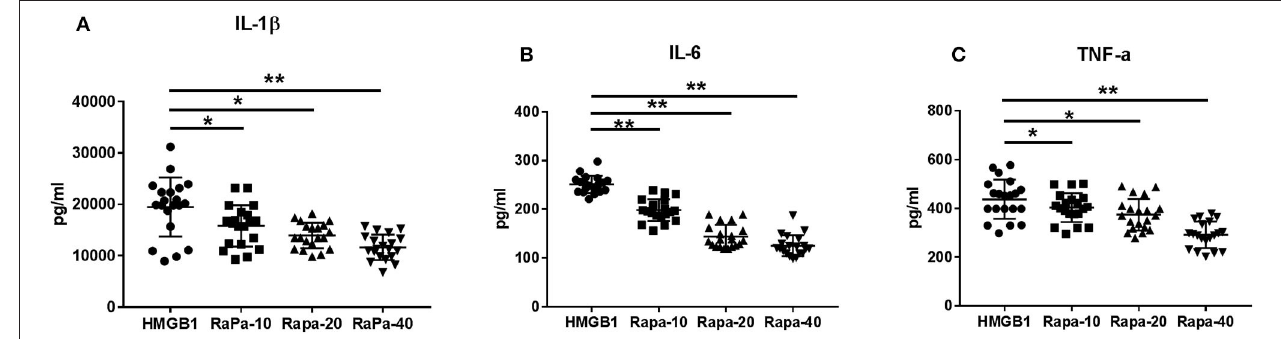
FIGURE 8 | Cytokine production through Rapa intervention. mDCs from systemic lupus erythematosus (SLE) patients were blocked by different concentrations of rapamycin, and production of IL-1 β (A) , IL-6 (B) , and TNF- α (C) were measured by ELISA. Different concentrations of rapamycin (Rapa-10: 10ng/ml; Rapa-20: 20ng/ml; Rapa-40: 40ng/ml) were added into cultures of primary mDCs. Data are presented as the median and interrogative range. * p < 0.05, ** p < 0.01. IL, interleukin; TNF, tumor necrosis